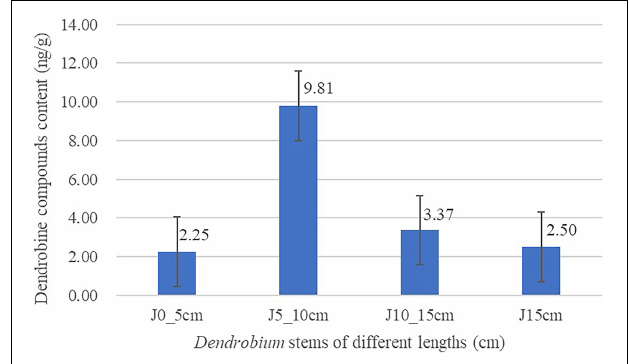
FIGURE 1 | Content of dendrobine in Dendrobium stems of different lengths. Three replicates for each condition. Error bars represent standard error ( n = 3).